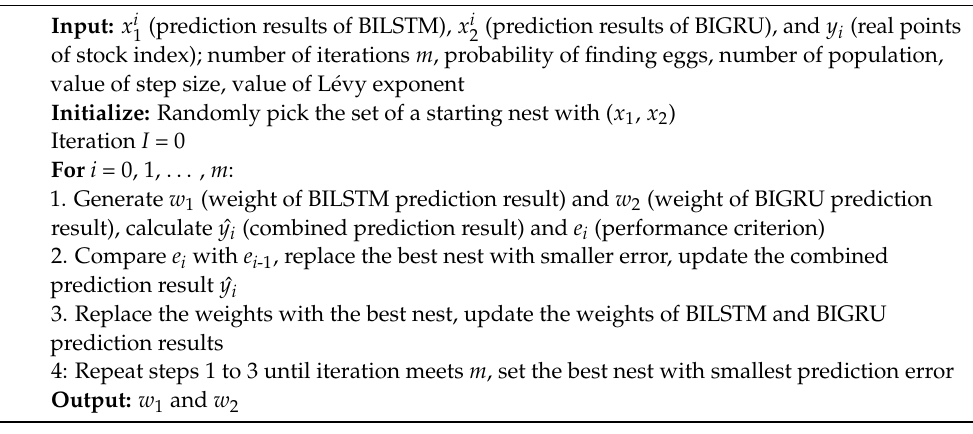
Algorithm 1 Principal of weighted cuckoo search